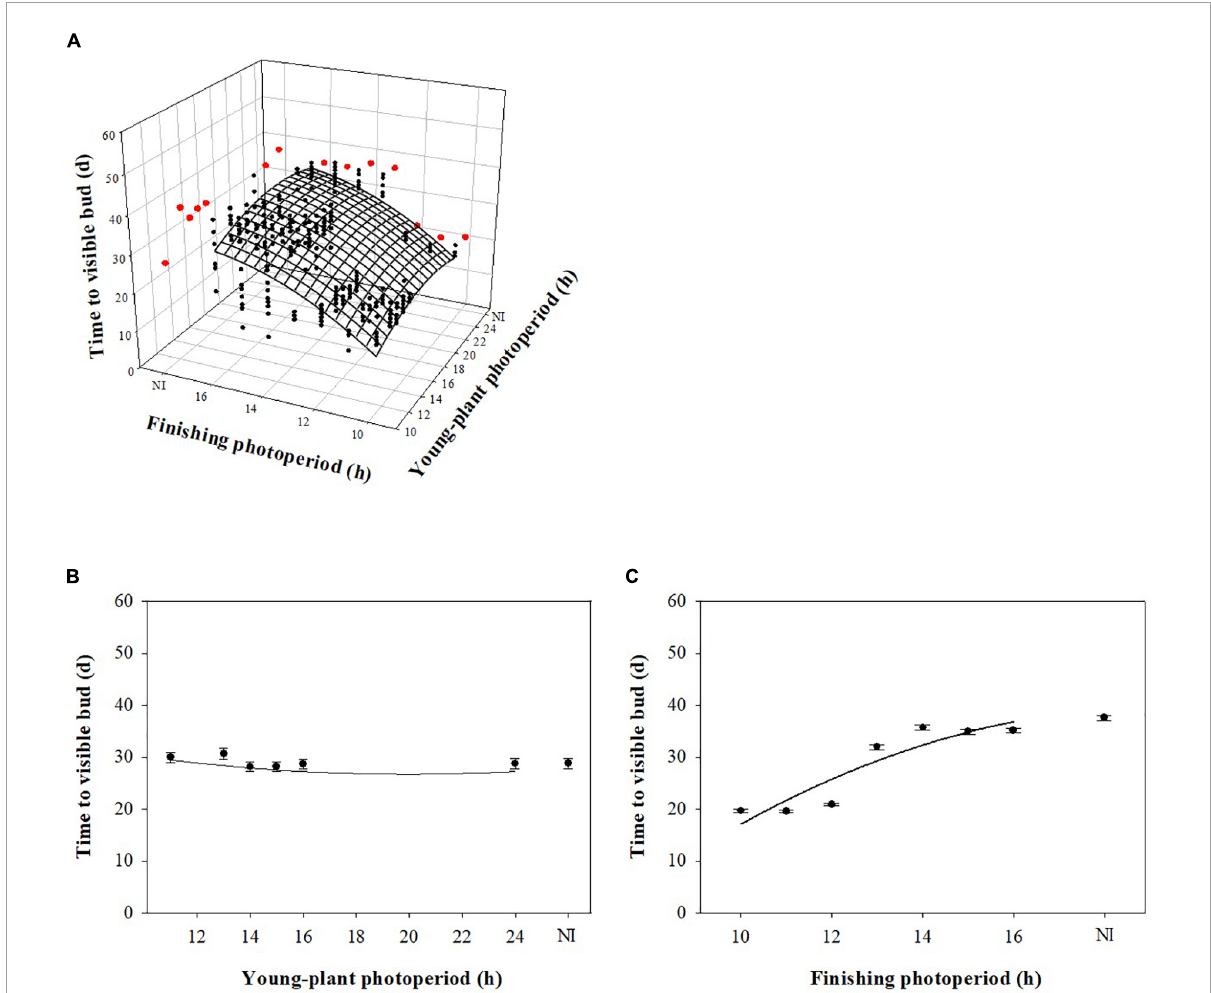
FIGURE3 Effect of young-plant photoperiod (11, 13, 14, 15, 16, and 24 h, or a 4-h NI) and/or finishing photoperiod (10, 11, 12, 13, 14, 15, and 16 h, or a 4-h NI) on time to visible bud (TVB) of marigold ‘Xochi’ ( Tagetes erecta ). Figures represent (A) the interaction between young-plant and finishing photoperiod on TVB of plants from replication 1, (B) the effect of young-plant photoperiod on TVB of plants from replication 2, and (C) the effect of finishing photoperiod on TVB of plants from replication 2. In panel (A) , black circles represent individual data points for sequential photoperiods; red circles represent averages from NI treatments. Coefficients are presented in Table 9